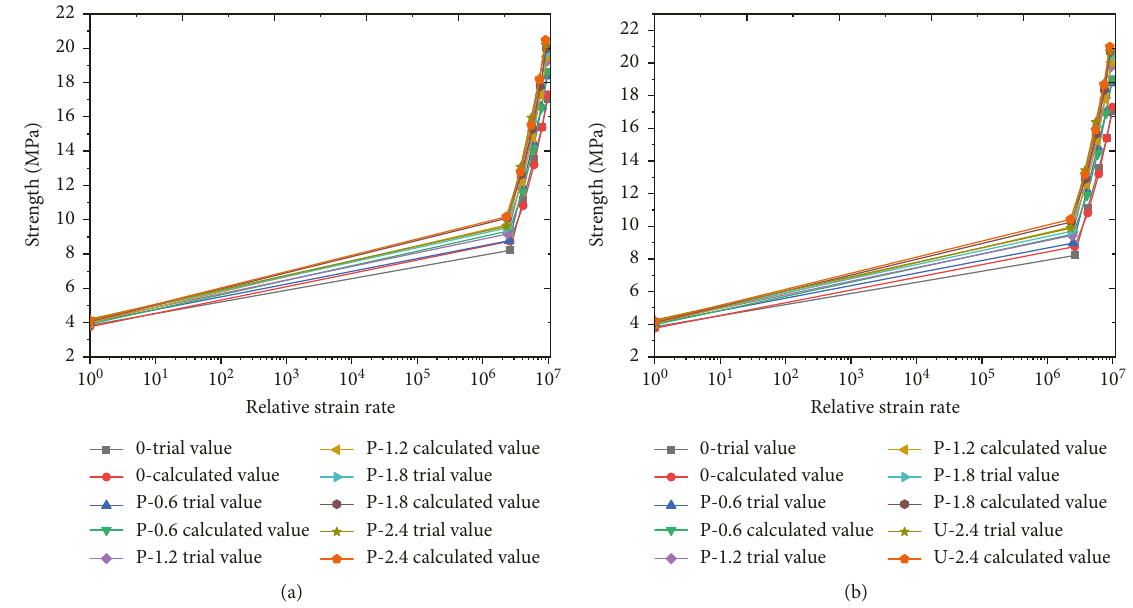
Figure 19: comparison between the experimental and the theoretical values by using the proposed